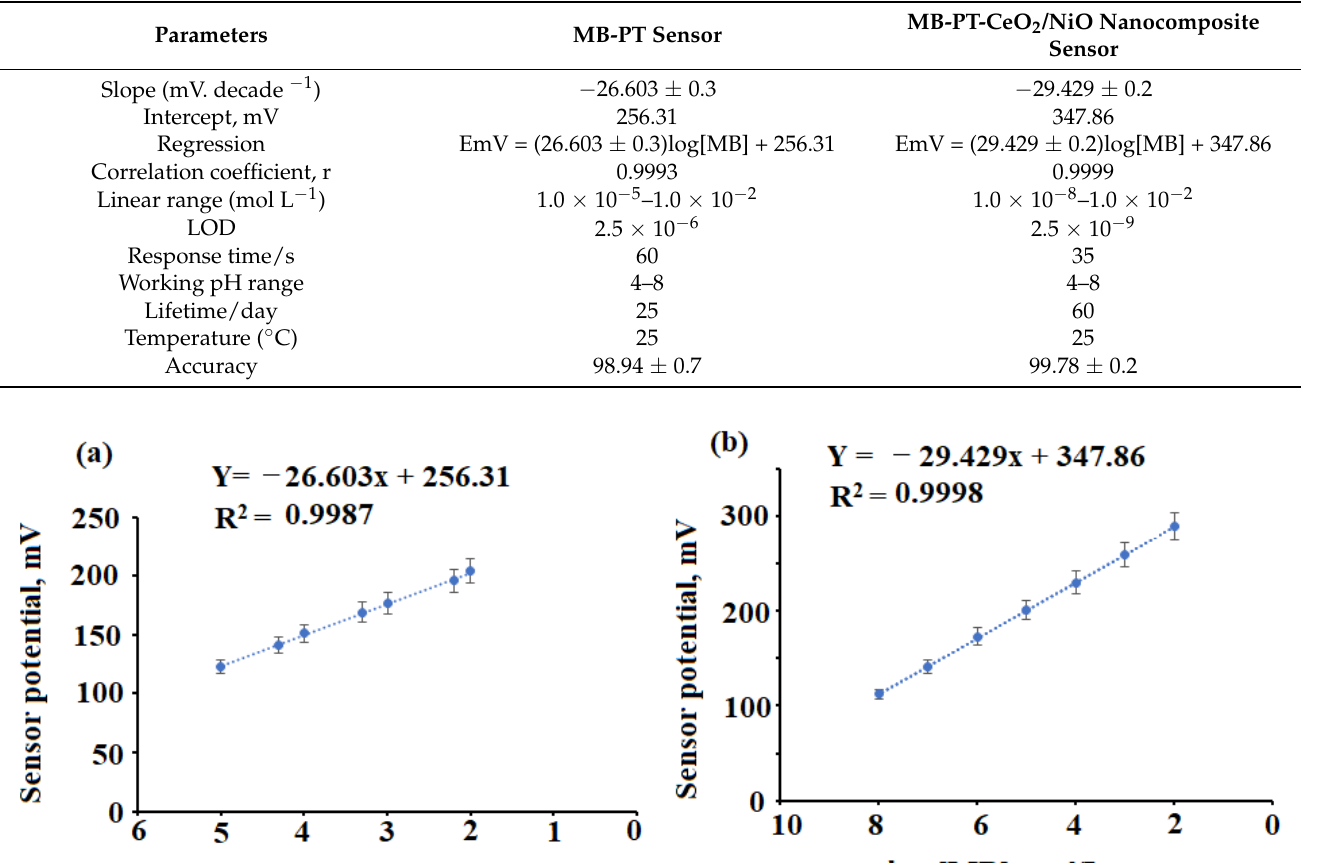
Figure 8. The suitable and independent pH range of the designed sensors MB-PT and MB-PT- CeO 2 /NiO nanocomposite using 1.0 × 10 −4 mol L −1 MB solution.